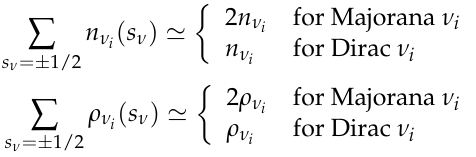
, due to neutrino clustering by our Galaxy and nearby galaxies i